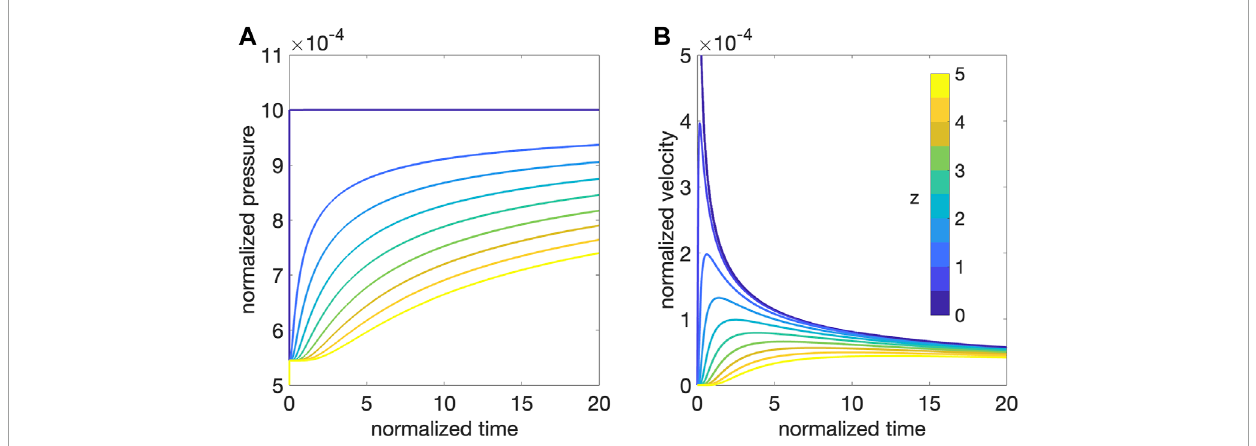
FIGURE 6 Example of pressure (A) and fluid velocity (B) evolution with time at multiple vertical locations obtained from the frequency-domain method. Colored lines show different vertical location (normalized by an arbitrary length scale [ l ] ). Time is normalized by the poroelastic diffusion time [ t ] = [ l ] 2 / c . Pressure in (A) is normalized by the poroelastic storage coefficient S −1 ; and Darcian velocity in (B) is normalized by the velocity scale [ l ]/[ t ] . At the source location z = 0, pressure is elevated at t = 0 and instantaneously transmits to the column via a fluid loading boundary condition. The transport of melt, pressure, and heat are driven by poroelastic diffusion, where there is no background temperature gradient and no viscoelastic relaxation. Other parameters used for (B) include melt bulk modulus K l = 1 GPa, shear modulus μ = 1 GPa, solid bulk modulus K s = 10 GPa, porosity ϕ = 0 . 3, and gas volume fraction in pore melt χ = 0.